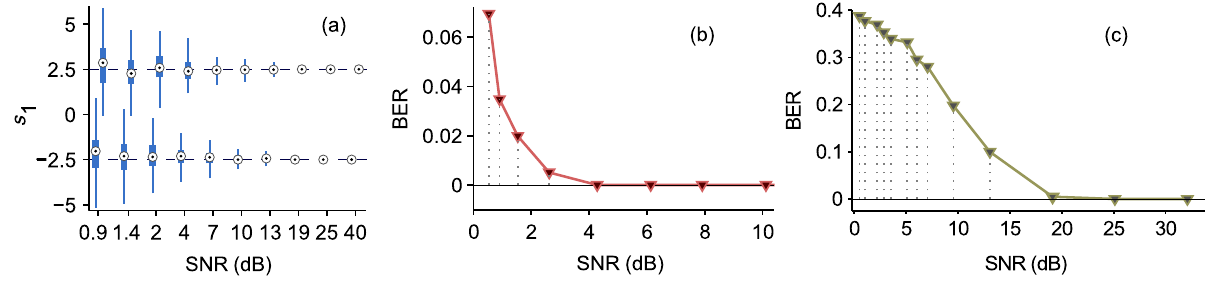
FIG. 3 Example of how noise affects the communication of a binary signal using the model [Eqs. (5) and (6)]. (a) Deviations of the demodulated signal from the initial binary states due to noise, presented as compact box plots (in terms of descriptive statistics: median, quartiles, max, and min) as a function of signal-to-noise ratio (SNR). (b) Bit-error rate (BER) of the coupling-function scheme as a function of SNR. (c) For comparison, BER of the signal-masking scheme as a function of SNR. In (a) and (b) the transmitted signal for coupling-function encryption has the two binary values s 1 ð t Þ ¼ f − 2 . 5 ; 2 . 5 g , while in (c) for signal-masking encryption, s 3 ð t Þ ¼ f 0 ; 5 g . In each run, 10 3 randomly ordered binary symbols are